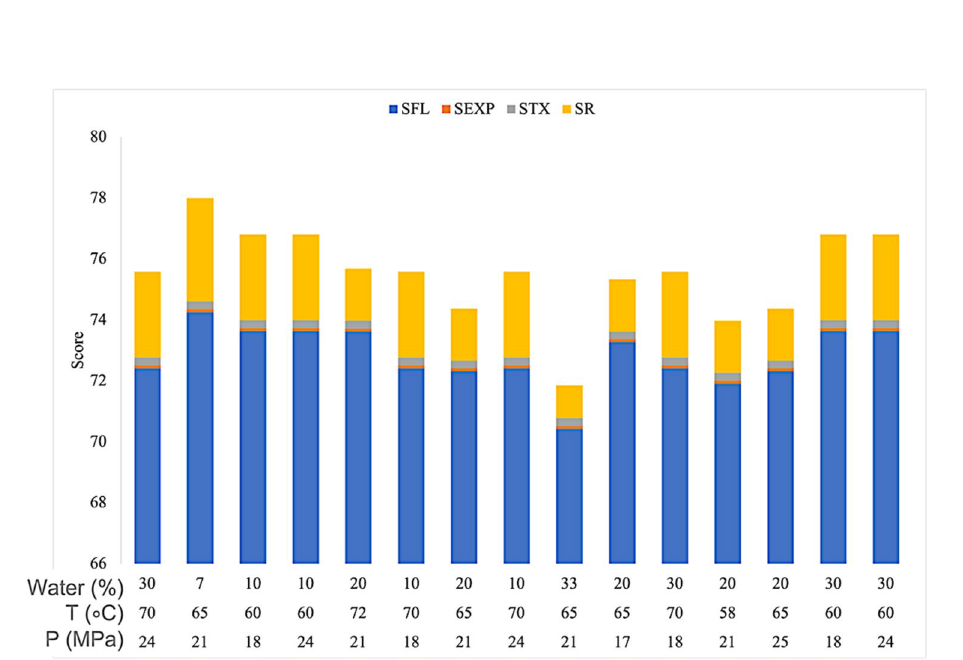
Figure 5. Individual factors in the CSTS score at each parameter for the SFE of G.